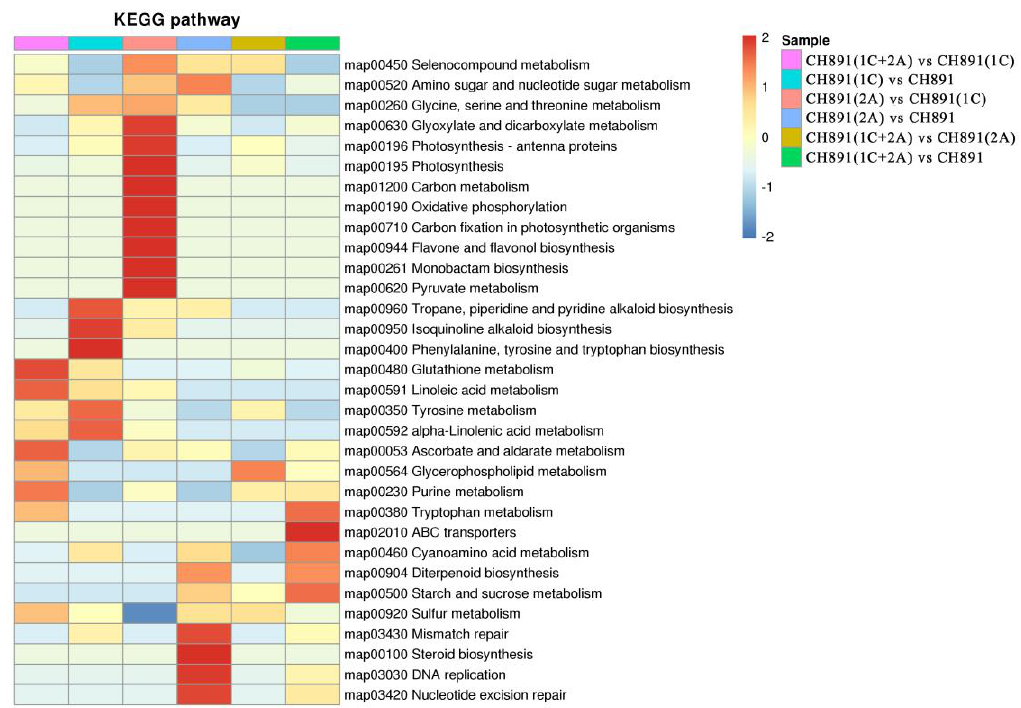
Figure 10. Kyoto Encyclopedia of Genes and Genomes pathways significantly enriched in sets of DEPs among samples of NIL groups. The enriched pathways included metabolic pathways by which secondary metabolites biosynthesis transport and catabolism.